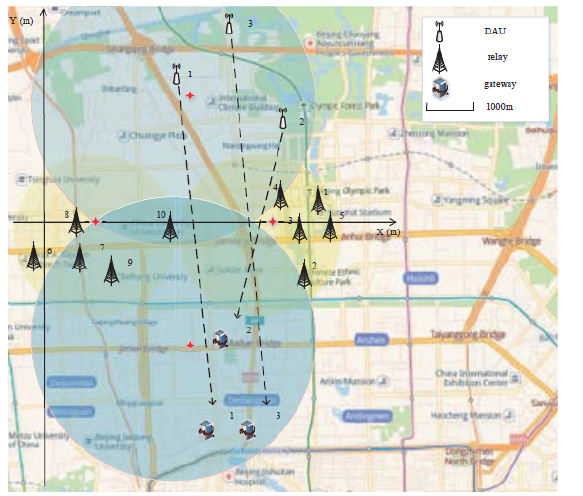
Figure 2. Topology of cooperative relay communication network (red crosses indicate the central points of the circles).